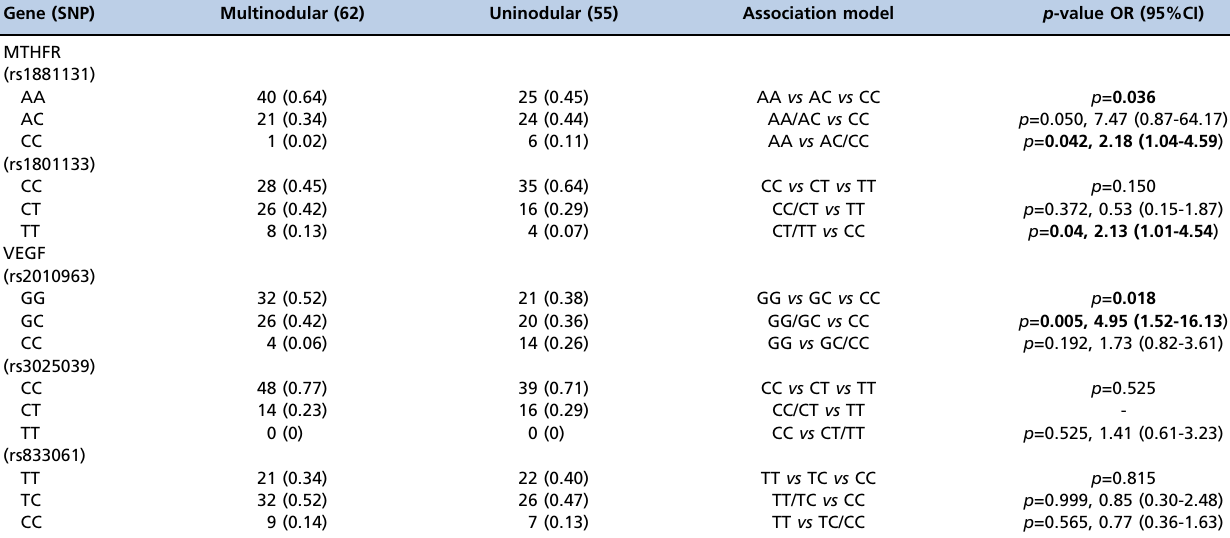
Table 4 - Analysis of the correlation between MTHFR and VEGF and the number of tumors in Brazilian patients with HCV-related HCC using genetic association models. Gene (SNP) Multinodular (62) Uninodular (55) Association